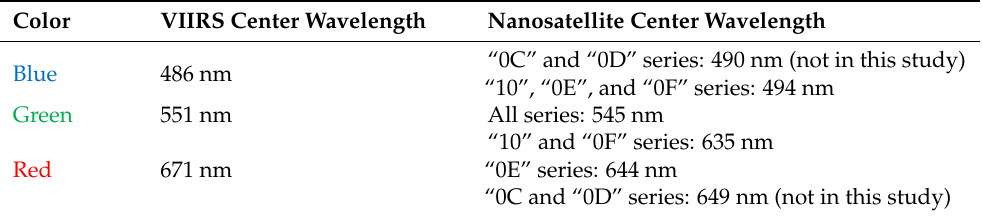
“0C and “0D” series: 649 nm (not in this